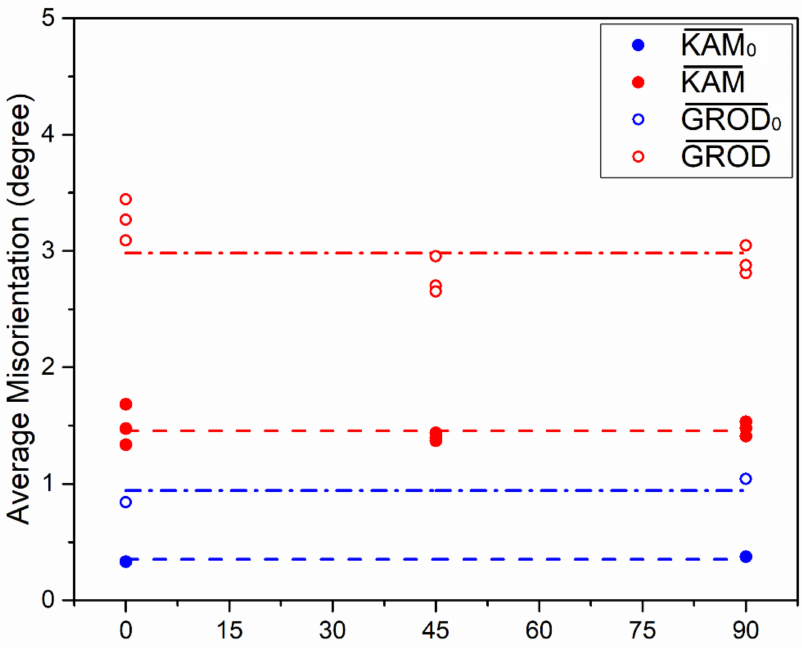
Figure 7. The average KAM and GROD values measured on 2D-EBSD observational planes with different angles to loading axis in both undeformed clamp sections and deformed gauge